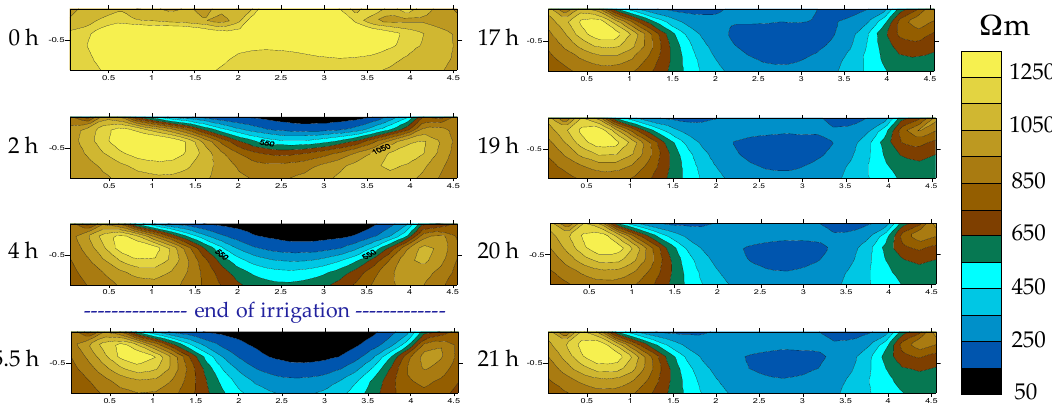
Figure 9. Grugliasco site, August 2009. Absolute ERT images along the transverse line (see Figure 3 for location).